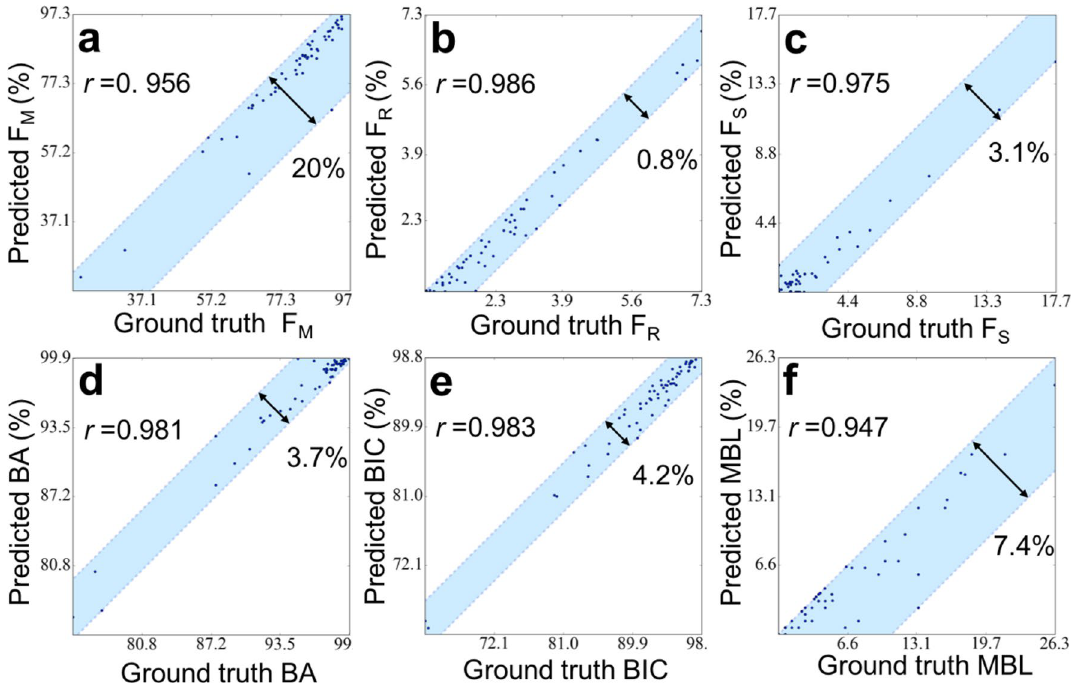
Figure 5. The predicted values vs. ground truth of six performance index (the percentage of mature bone (F M ), bone resorption (F R ) and soft tissue (F S ), bone area (BA), bone-implant-contact (BIC), and marginal bone loss (MBL)) for all the 65 dental implants.